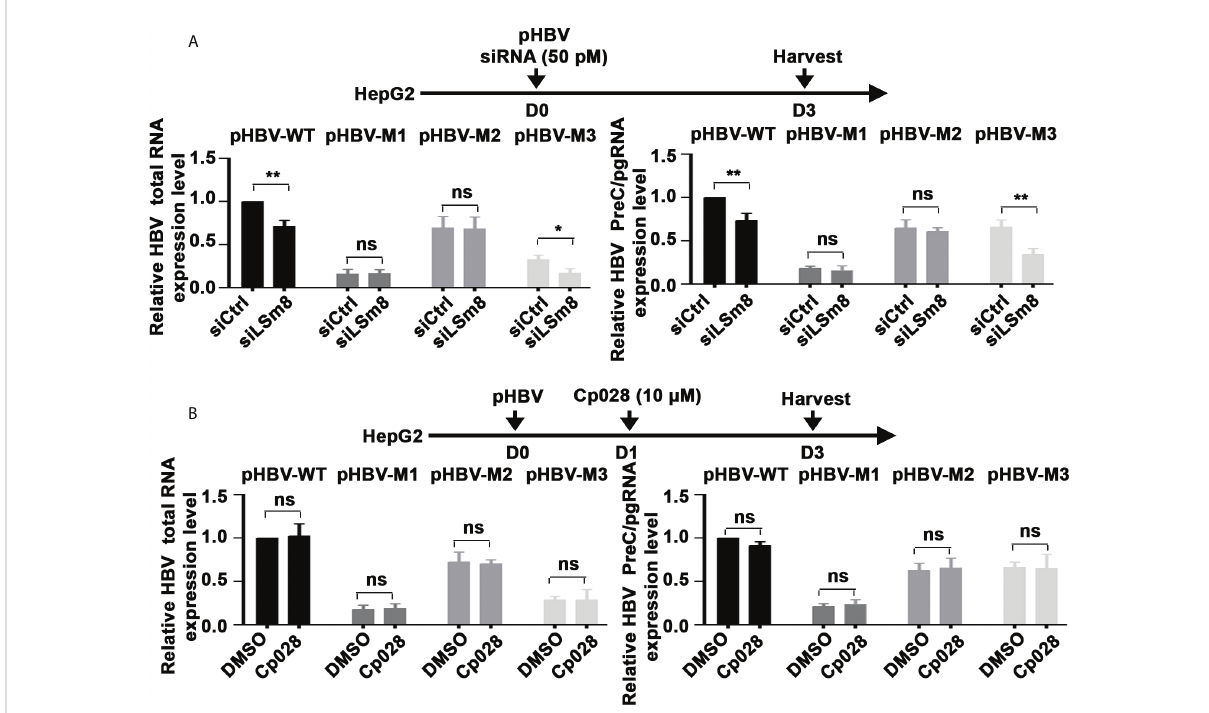
FIGURE 6 The LSm2-8 complex is required for the 5 ’ m6A modi fi cation. (A) and (B) Timeline of transfections of 1.3mer HBV plasmid DNA and 50 pM of indicated siRNAs in HepG2 cells (A) or with addition of 10µM Cp028 (B) . pHBV-WT, pHBV-M1, pHBV-M2 and pHBV-M3 (1.0µg each per 6-well plate) transfected by lipofectamine3000 in HepG2 cells. RNA extracted from day3 transfected HepG2 cells, immunoprecipitated with anti-m6A or IgG, and total HBV RNA and preC/pgRNA quanti fi ed by RT-PCR. Results expressed relative to IgG. n=3 *p<0.05, **p<0.01. ns, not signi fi